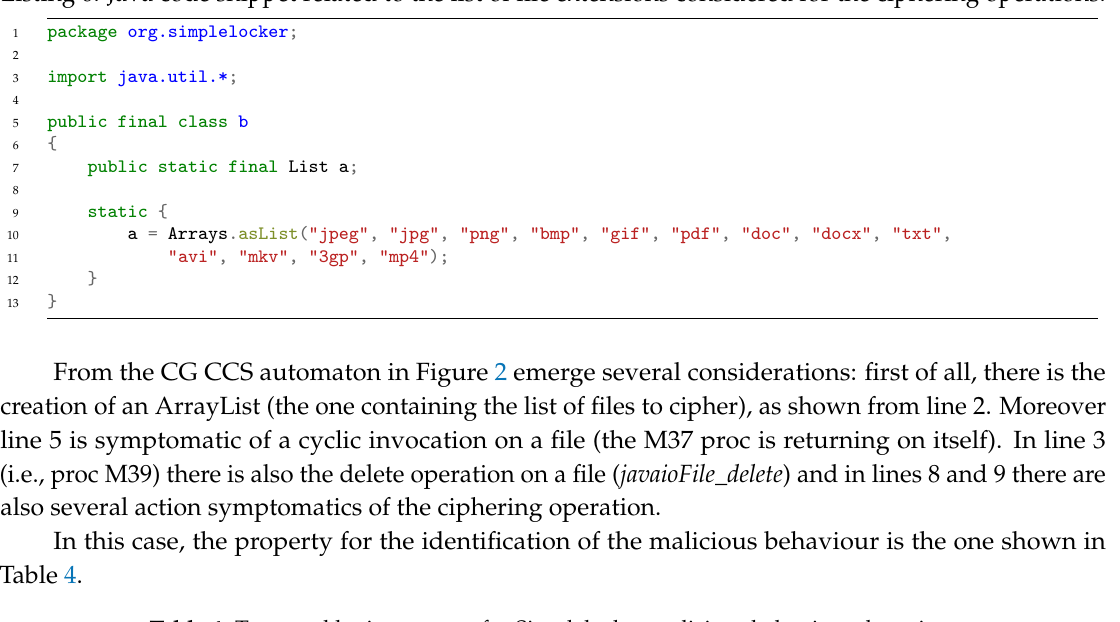
Table 4. Temporal logic property for Simplelocker malicious behaviour detection.